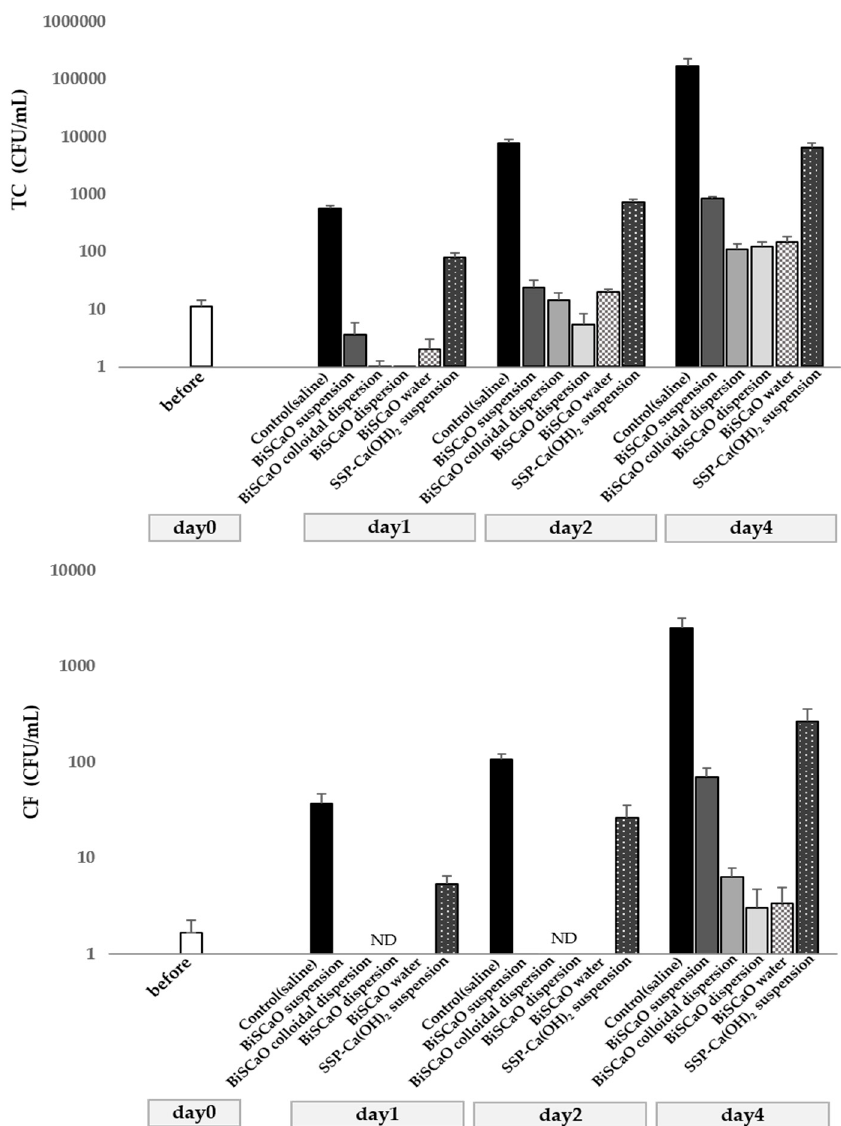
Figure 1. Anti-microbial e ffi cacy of BiSCaO-based disinfectants. The number of CFU / mL of TC ( upper ) and CF ( lower ) in 1 g of raw Japanese horse mackerel cleaned with each BiSCaO disinfectant after incubation for 1, 2, and 4 days were counted after vigorous vortexing with 10 mL of pure water for 30 s ( n = 3). Pure water was used as the control. ND indicates not detected.